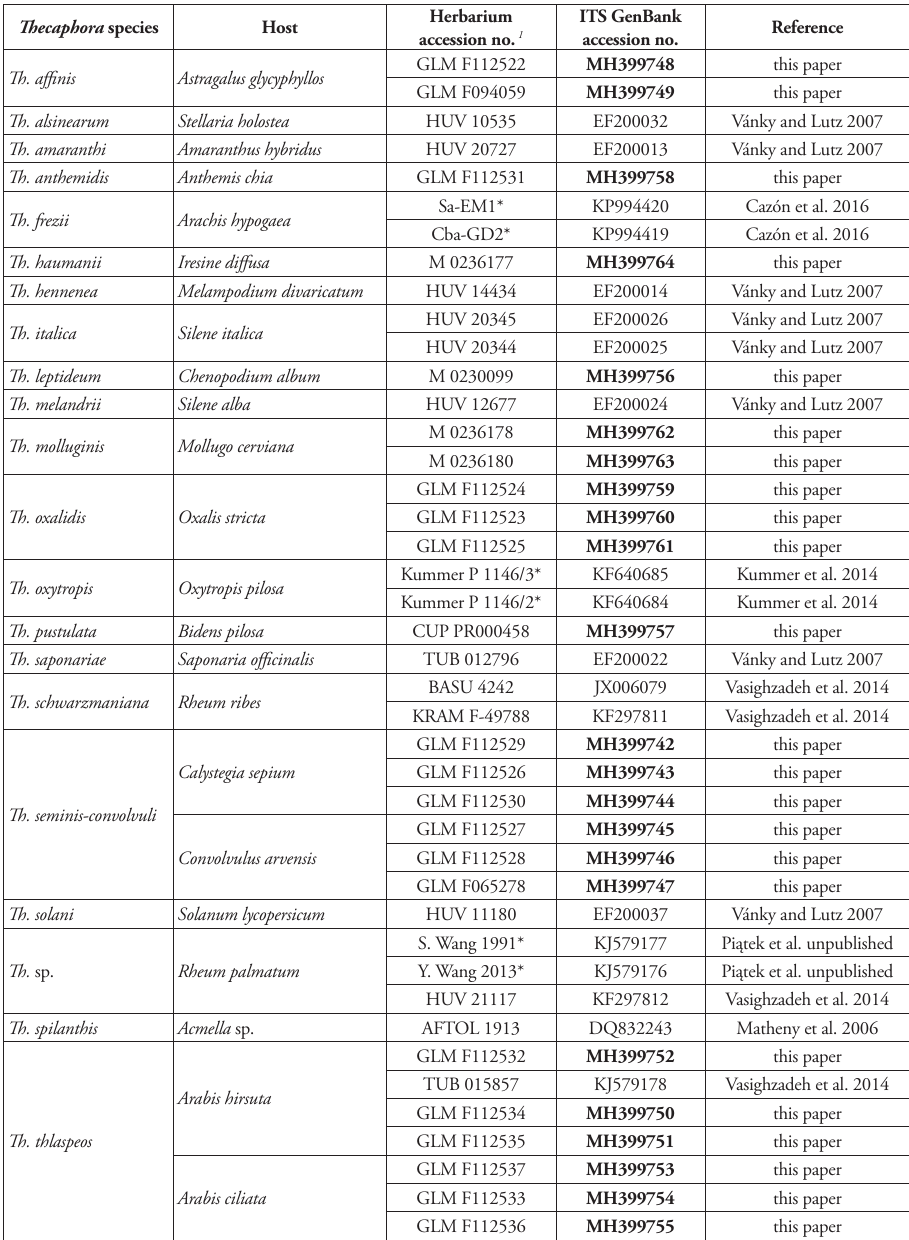
Table 2. Specimens and GenBank sequences used for phylogenetic analyses. Sequences generated in this study are shown in